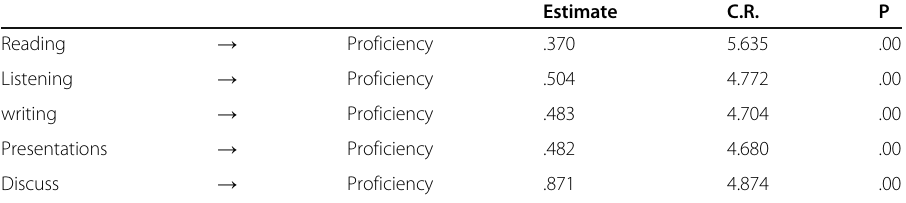
Table 6 Standardized Regression Weights: (data - Default model)